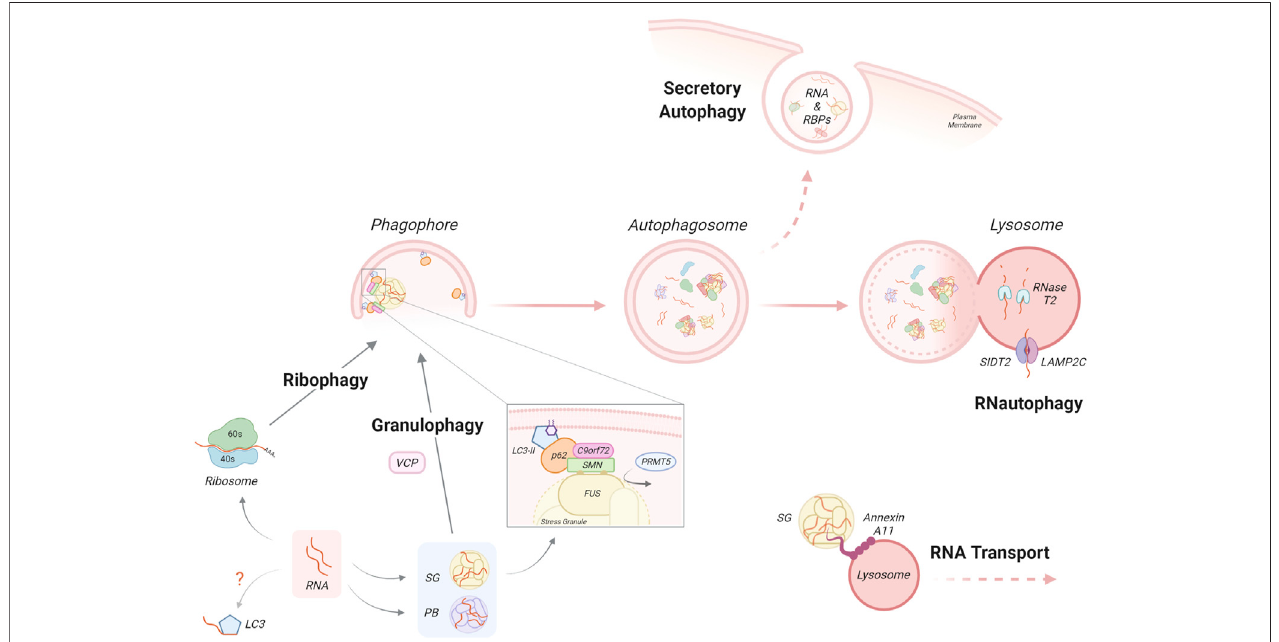
FIGURE 2 | Autophagy-dependent RNA homeostasis. Autophagy-dependent RNA catabolism involves the degradation of RNA, RNA-binding proteins and RNA granuleswithinthelysosomallumenbyRNasessuchasRNaseT2andlysosomalacidichydrolases.Through RNautophagy ,mRNAmoleculesaretakenupdirectlyinto the lysosome through SIDT2 or LAMP2 proteins, in an ATP-dependent manner. Unbound RNA can also directly interact with LC3 via its arginine-rich motif however the impact ofthisrequires furtherinvestigation. Ribophagy isamechanismfor autophagy dependent ribosome clearance bywhich ribosomes areengulfedwithin the autophagosome and delivered to the lysosome for degradation. mRNA can associate with RNA-binding proteins and accumulate in dynamic RNA granules such as stress granules (SG) or P-bodies (PB). Granulophagy is the process by which SGs are recruited for selective autophagy, which may involve the protein VCP. An additional mechanism ofSG recruitmenthas been proposed, bywhich the PRMT5-dependent symmetric arginine methylation ofSG components, such as FUS, allows for their recognition by the p62/C9orf72 complex via the SMN protein. Autophagy-dependent RNA catabolism is also impacted by the transport and secretion of RNA/ RNA complexes. RNA transport involves SGs and other RNA complexes hitchhiking on motile vesicles, a process that involves the docking of RNA granules via molecular tethers. Notably, the ALS-associated RBP Annexin A11 is a component of SGs and can also bind lysosomes that are transported along microtubules. The autophagymachinery isalso involvedin thenon-canonicalautophagyfunction of secretoryautophagy .Bythisprocess, thecontentsofautophagosomes,whichmay contain RNA and RBPs, bypass degradation and instead are directly secreted from the cell.